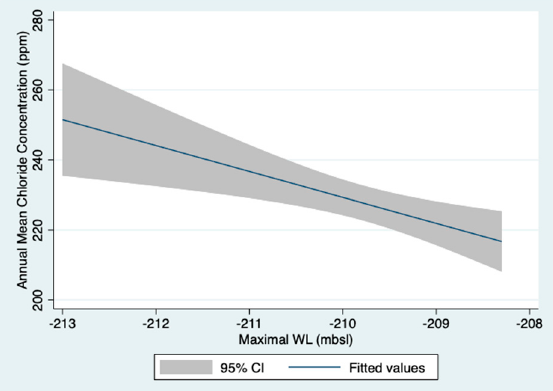
Figure 3. Trend of changes (Lowess smoother, 0.8 bandwidth) of annual lake average of chloride concentration (ppm). Two periods are presented: Left—1934–2005 and Right—1969–2001.